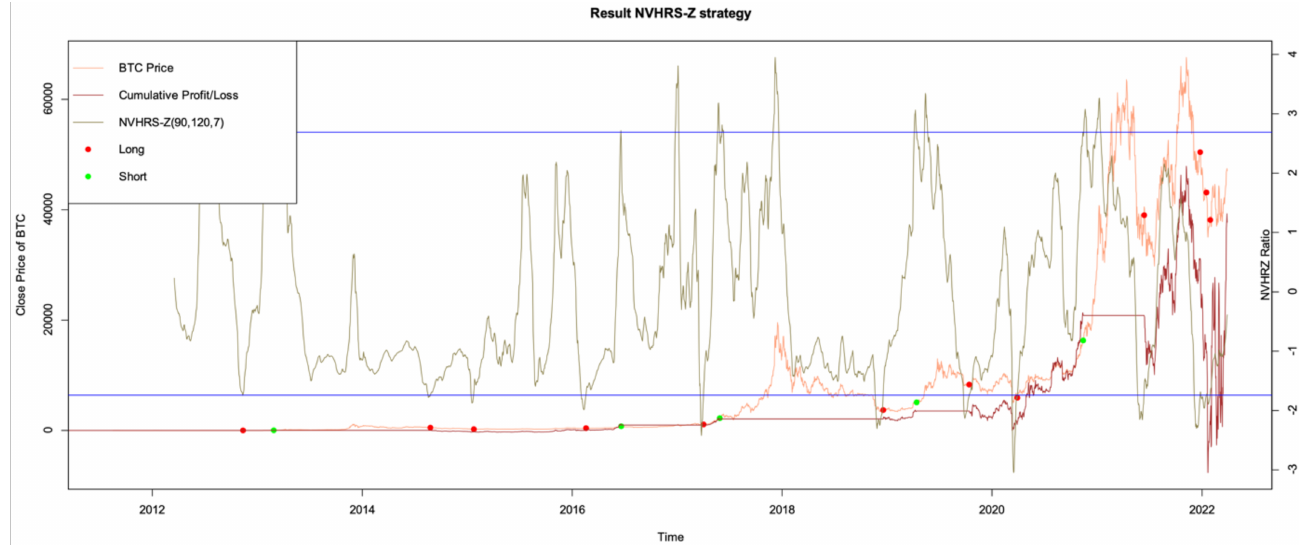
Figure A3. NVHRS-Z strategy: BTC price (orange line, left-hand side), cumulative profit/loss (red line, left-hand side), NVHR S-Z ratio (brown line, right-hand side), long and short thresholds (blue lines, right-hand side), long orders (red points), and short orders (green points).